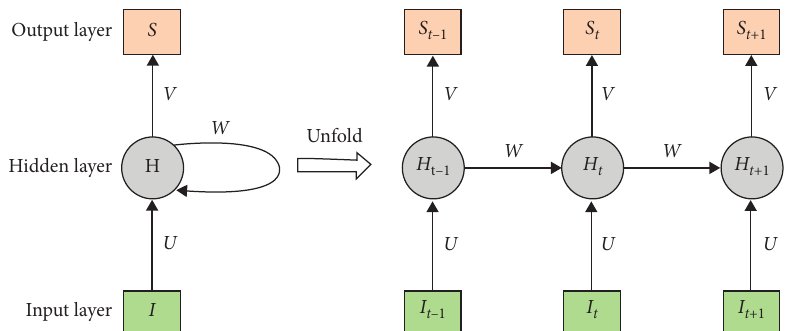
Figure 1: Unfolded drawing of the cyclic neural network model.